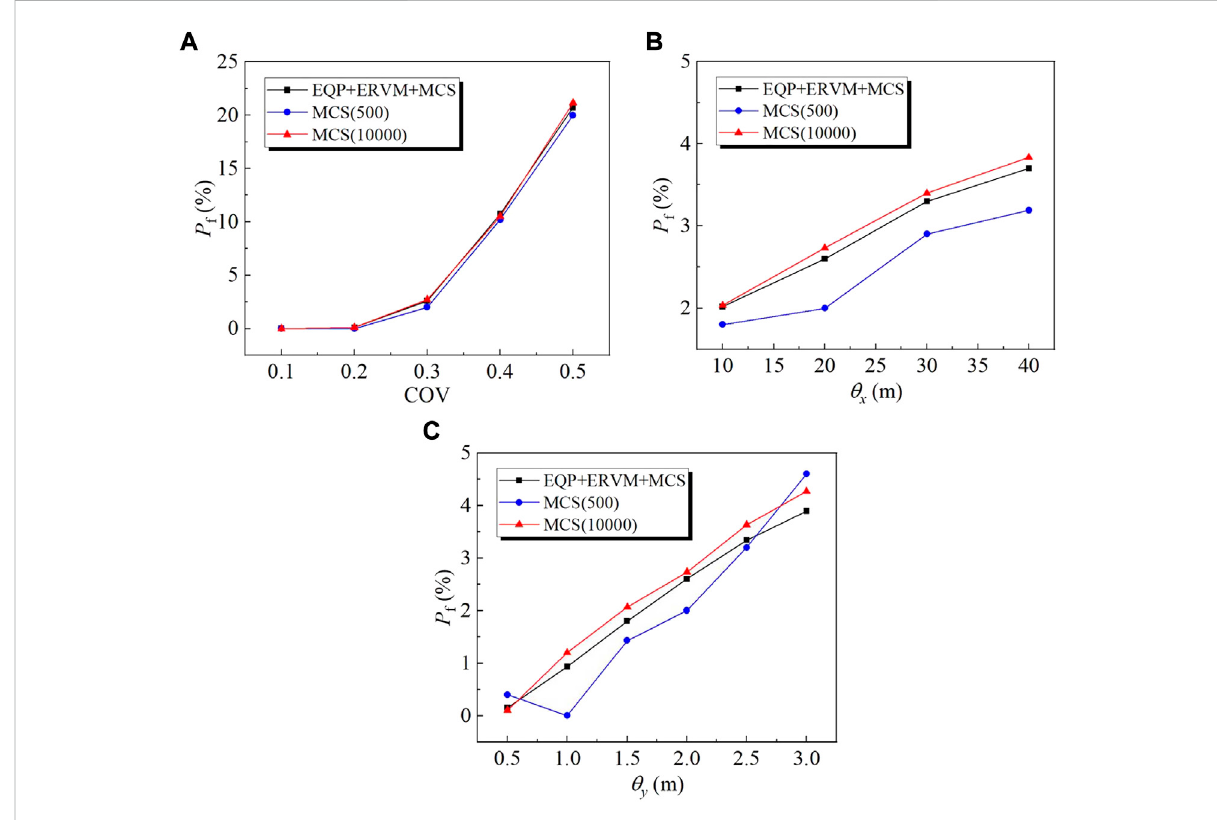
FIGURE 9 Parametric study on (A) COV, (B) θ x , and (C) θ y